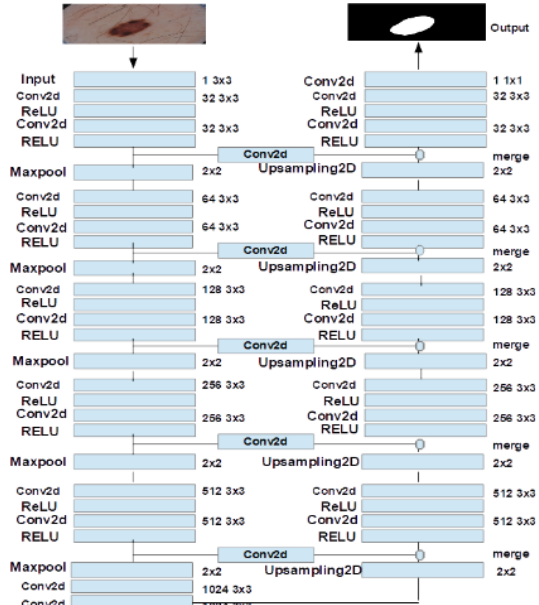
Figure 2. Layout diagram for a fully convolutional deep learning system.